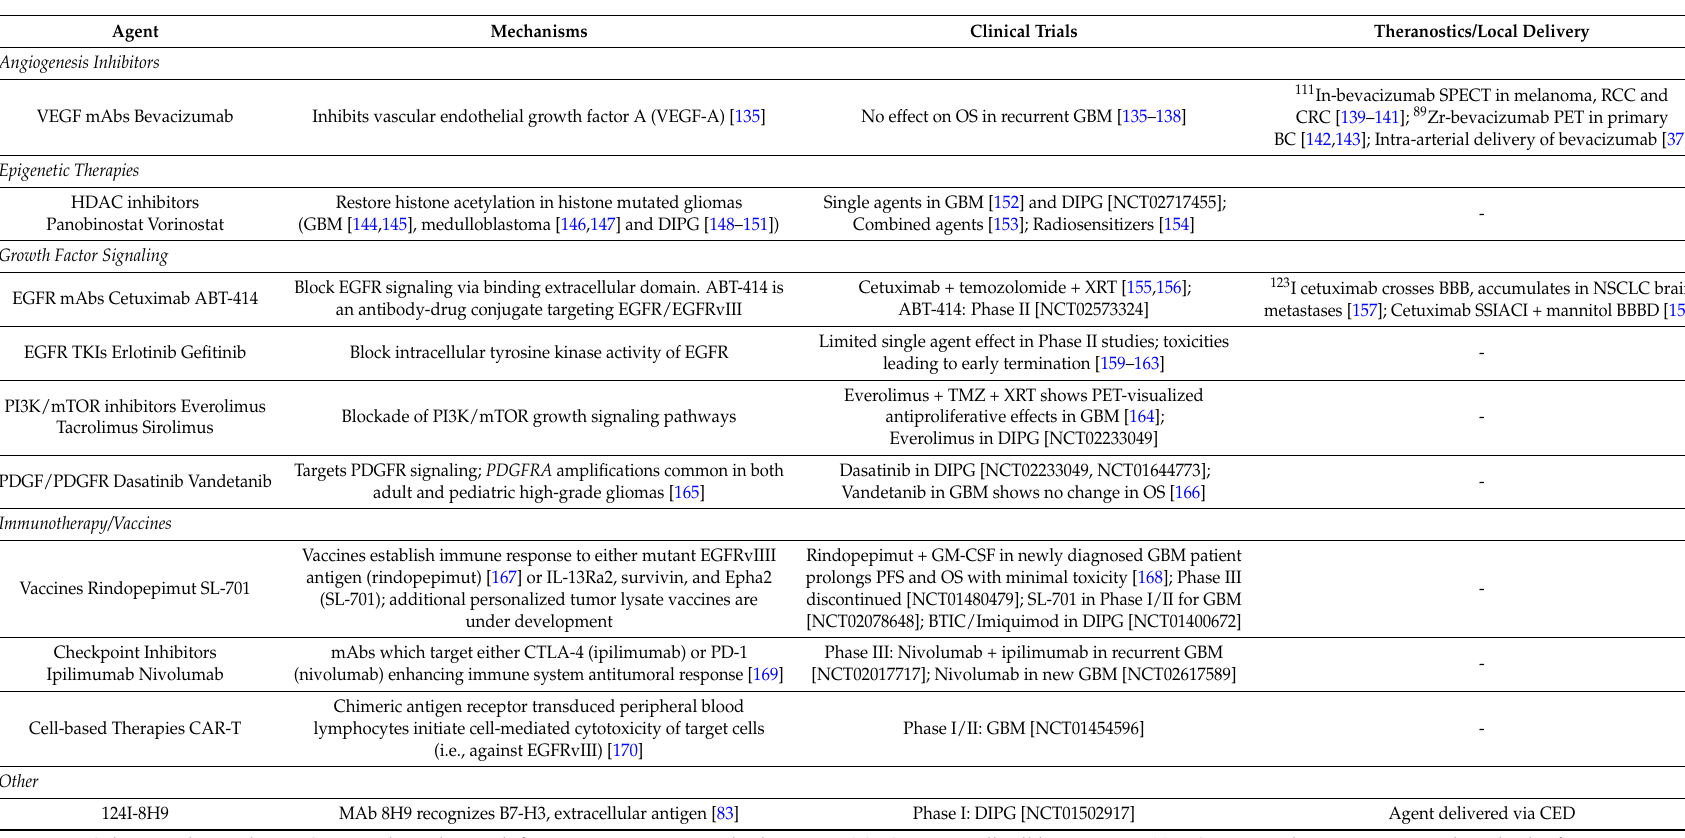
Table 1. Current molecularly targeted molecular therapies under development and in ongoing clinical trials for central nervous system (CNS) tumors, highlighting attempts at theranostics and local delivery in the clinical